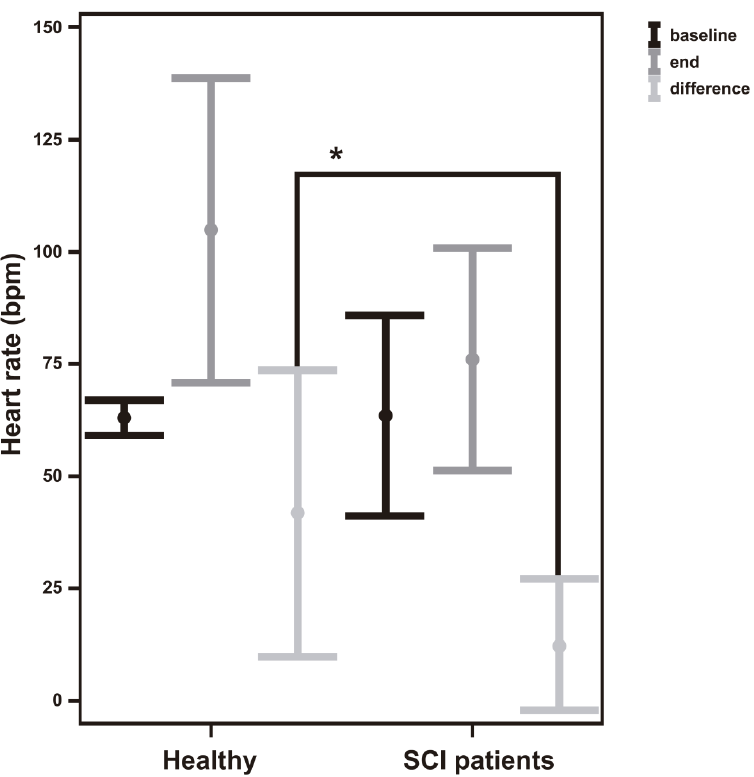
Figure 3. Mean heart rate measurements for neurologically healthy participants and SCI patients at baseline before the experimental session (black lines) and at the end of the experimental session (gray color), and the oscillation range (light gray color). * Significant statistically differences ( p < 0.05). Within the last experimental session, statistically significant differences were found between the two groups in the maximum value of heart rate and the oscillation range measured. The maximun value was higher in healthy people (149.50 ± 64.50) than in SCI patients (100.50 ± 20.75, p < 0.05) and, as a consequence, this difference was found in the oscillation range in healthy vs. SCI patients (92.50 ± 65.50 > 44.50 ± 14.25, p < 0.05). The effort perception, analyzed through the Borg scale, was greater for the SCI patients group than for the healthy individuals, but no significant differences were found. 3.3. Variables at Baseline and at Ending the Complete UL Training In this case, the variables related to the Krupp scale and the number of UL movements were analyzed, and the results are shown in Table 3. Table 3. Results in the Krupp scale and the UL movements number at baseline (before starting the training) and at the end of all the experimental sessions. Baseline